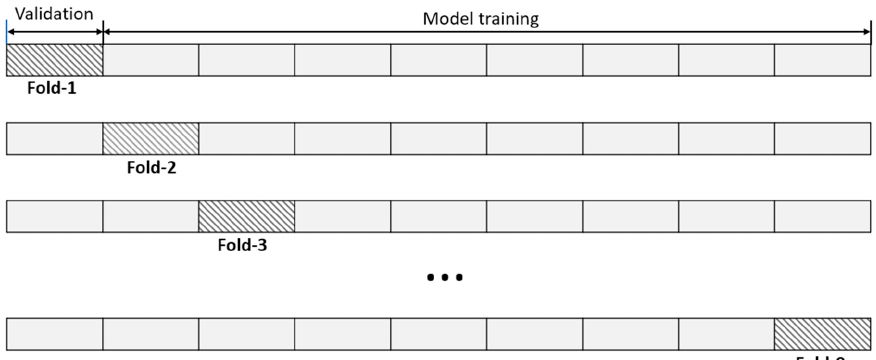
Figure 2. The illustration of the nine-fold cross-validation. The dataset is divided into nine random subsets; from there, eight are used for training and one for validation. This process is repeated nine times with different subsets for validation.